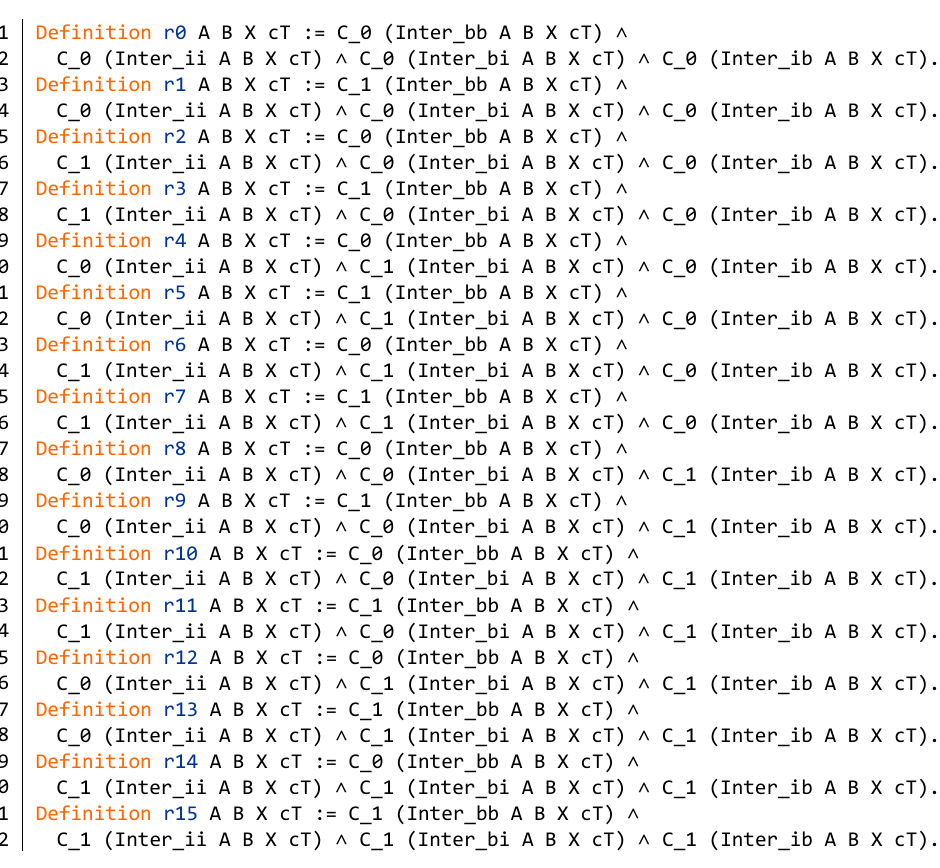
Figure 3. The formal description of the intersection